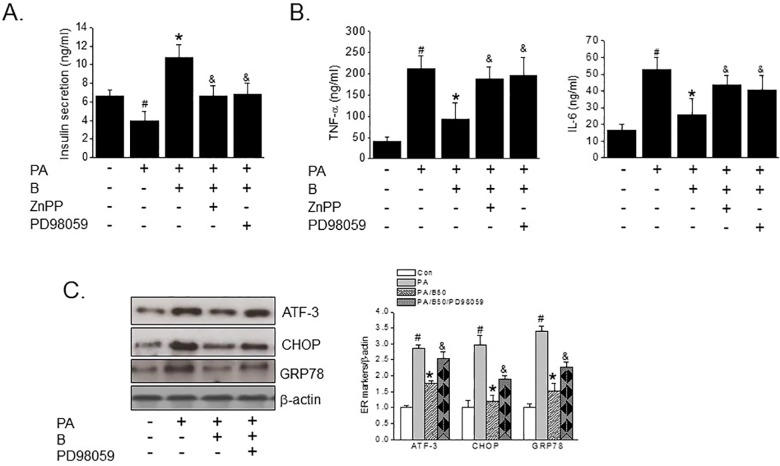
Effects of baicalein on PA-induced inflammation and reduced insulin secretion.INS-1 cells were pretreated with either ZnPP (10 μM) or PD98059 (10 μM) for 30 min, followed by baicalein (50 μM) for 3 hr. And then PA (500 μM) was added and further incubated for 24 h. To examine glucose-stimulated insulin secretion, culture medium was replaced with medium containing 25 mM glucose for 1 h, and then insulin secretion to medium was measured by ELISA (A). INS-1 cells were pretreated with baicalein (50 μM) for 3 h in the absence or presence of ZnPP (10 μM), or PD98059 (10 μM) and then PA (500 μM) was added and incubation continued for a further 8 h (for qPCR) or 24 h (for western blot). Levels of TNF-α and IL-6 were assessed by ELISA (B). The protein levels of ER stress markers were determined by Western blotting (C). The results shown are representative of three independent experiments and are expressed as means ± SDs. #P<0.05 vs. controls; *P<0.05 vs. PA alone; &P<0.05 vs. PA plus baicalein treatment.